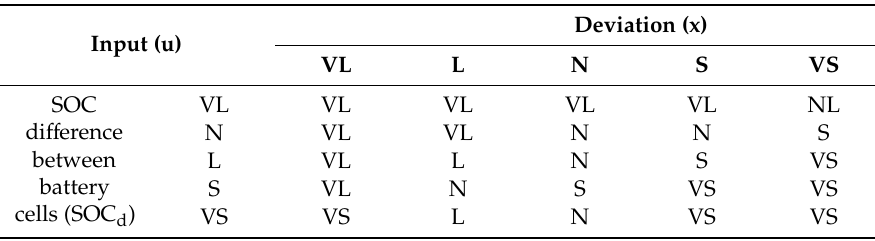
Table 5. Definition of the membership